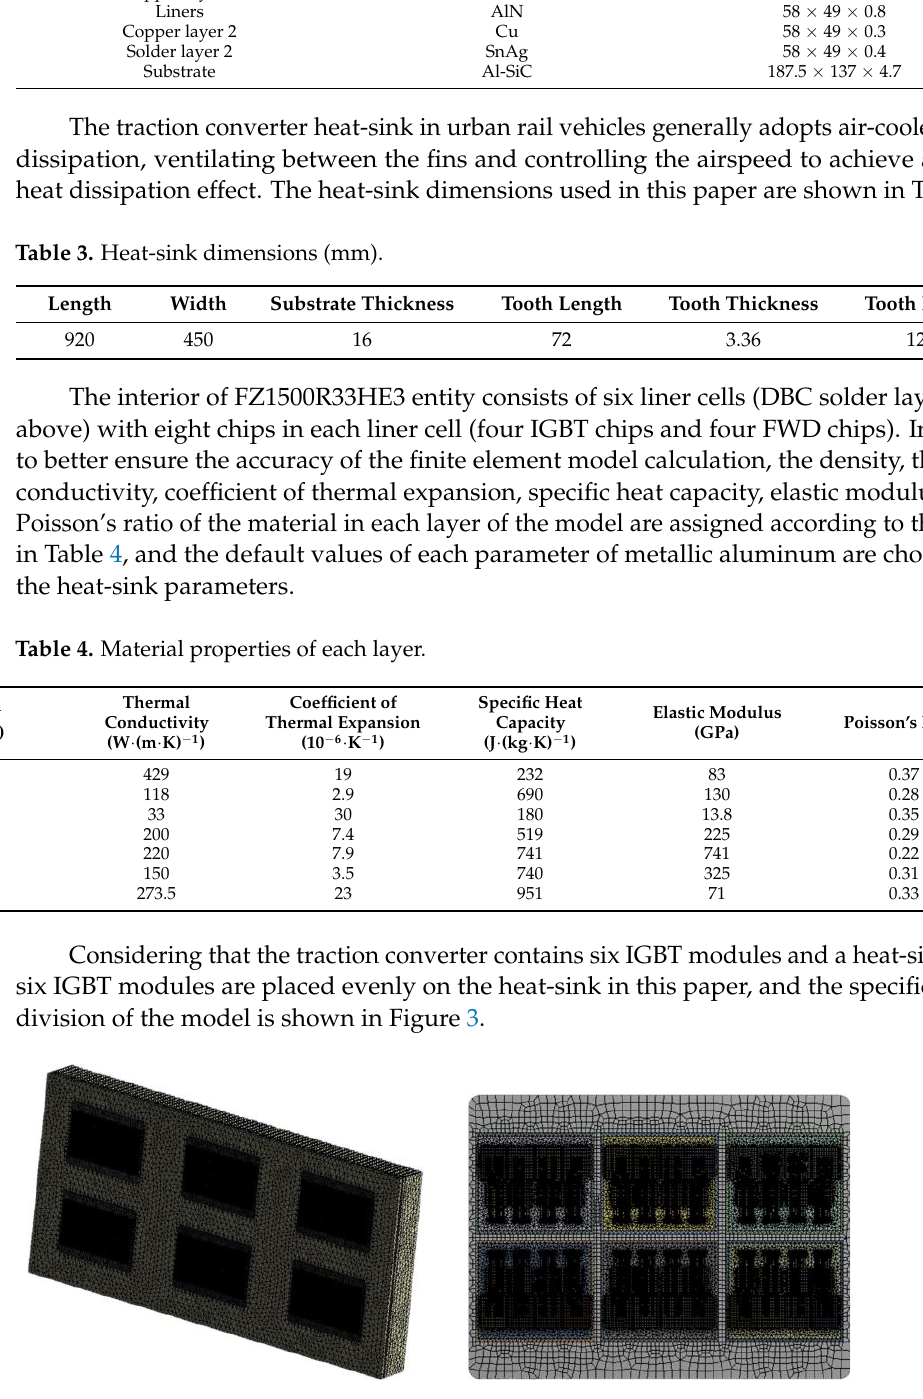
Table 3. Heat-sink dimensions (mm).